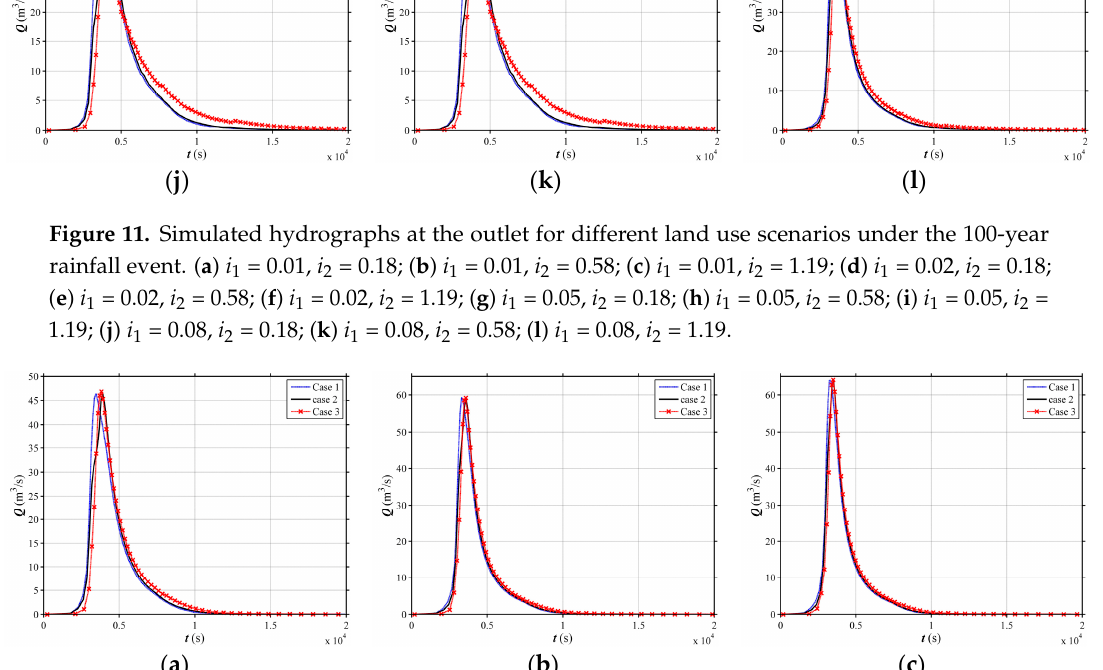
i i ) in the V-shaped ) in the V-shaped